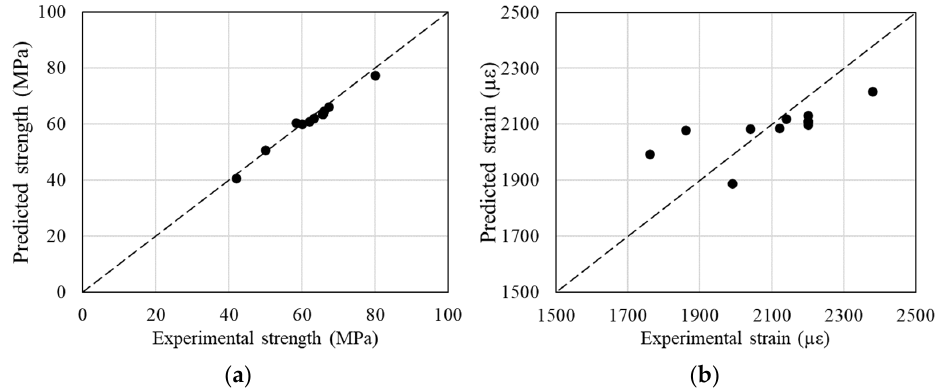
Figure 15. Comparison between the experimental and predicted results: ( a ) compressive strength; ( b ) ultimate strain.